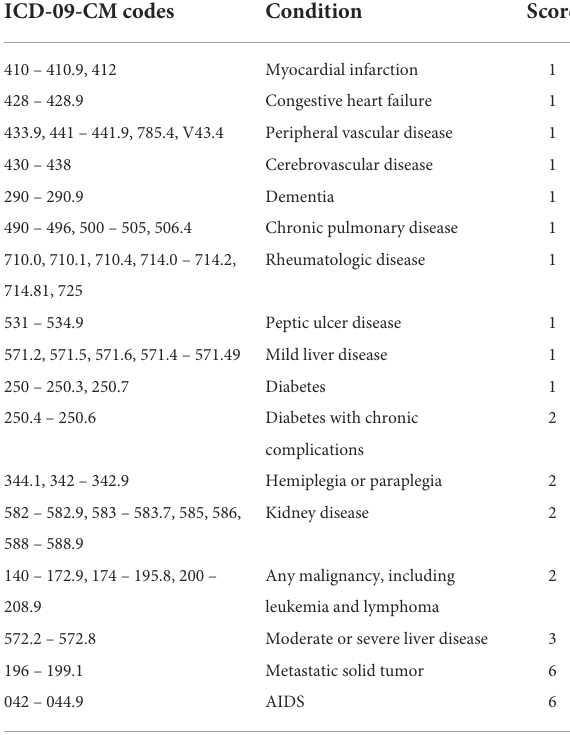
TABLE 1 Classification of lipid-lowering drugs according to their ability to reduce cholesterol.